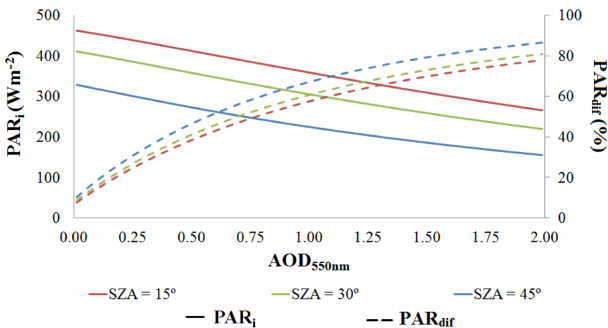
Figure 4. PARi (Wm − 2 ) (continuous lines) and PAR dif (%) (dashed lines) versus AOD550nm, for three different SZAs (15, 30, and 45 ◦ ) calculated by the radiative transfer model, libRadtran, for Bananal Island for a characteristic day of the dry